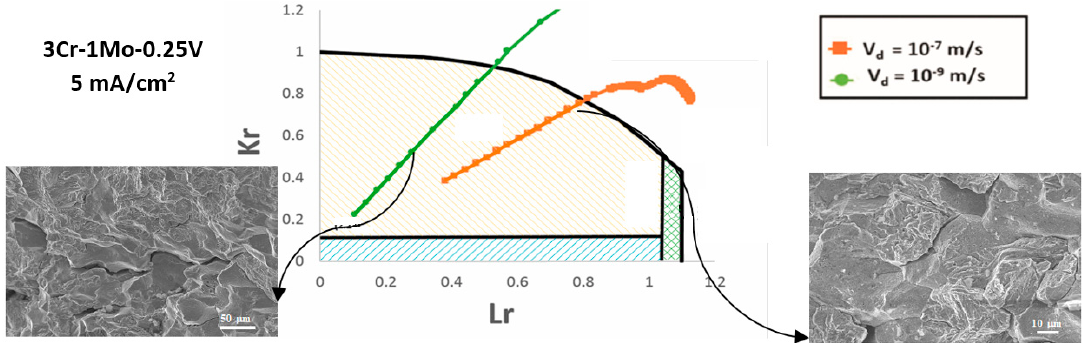
Figure 19. Crack path propagation displayed on the FAD, and fractography, from the slow rate tests performed on 3Cr-1Mo-0.25V steel under 5 mA/cm 2 CC environment at 10 − 7 and 10 − 9 m/s.